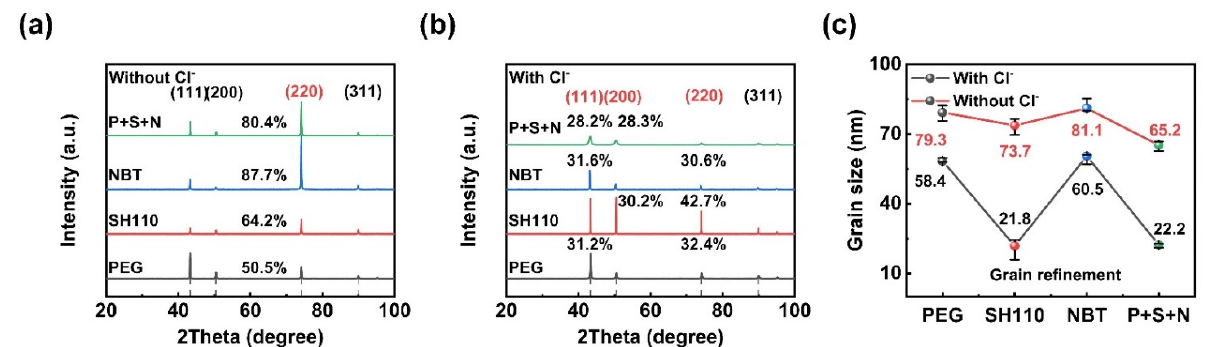
Figure 9. XRD analysis of the electrodeposited Cu layer in the electrolyte: ( a ) with Cl − , ( b ) without Cl − , and ( c ) grain size and TC.